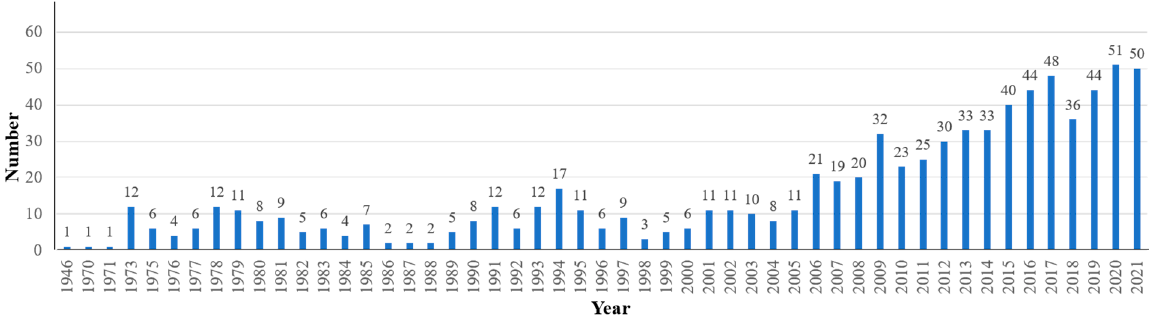
Figure 2. Distribution of articles published on art therapy (AT)-aided health and well-being in three quarters of a century, 75 years from year 1946 to September 2021 in ScienceDirect (devised by the authors).